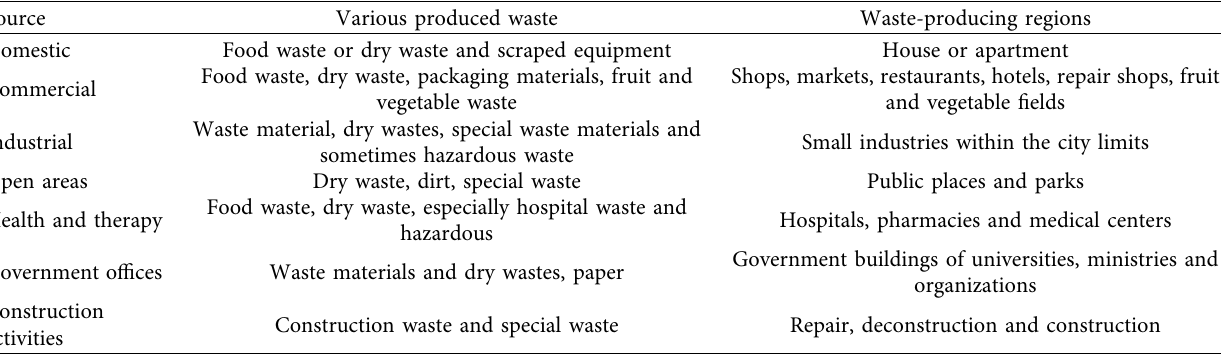
Table 1: The sources of waste products in the city of Germi [https://pasmand.ardabilcity.ir].